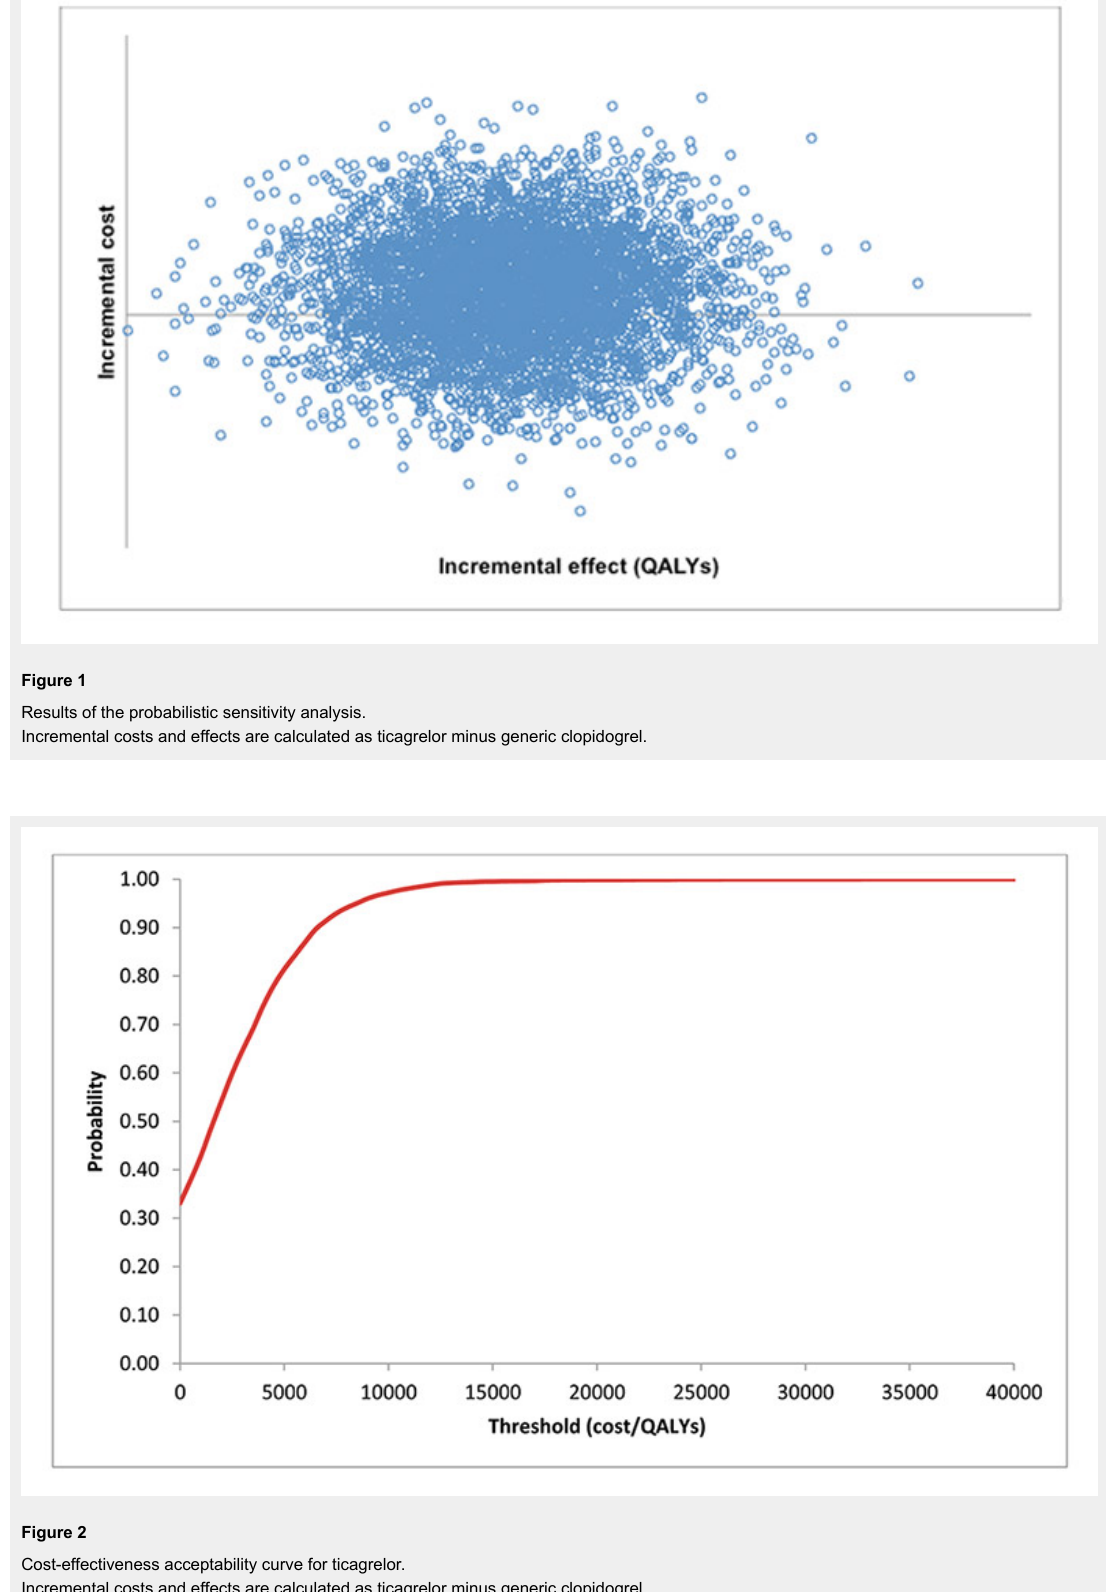
Figure 2 Cost-effectiveness acceptability curve for ticagrelor. Incremental costs and effects are calculated as ticagrelor minus generic